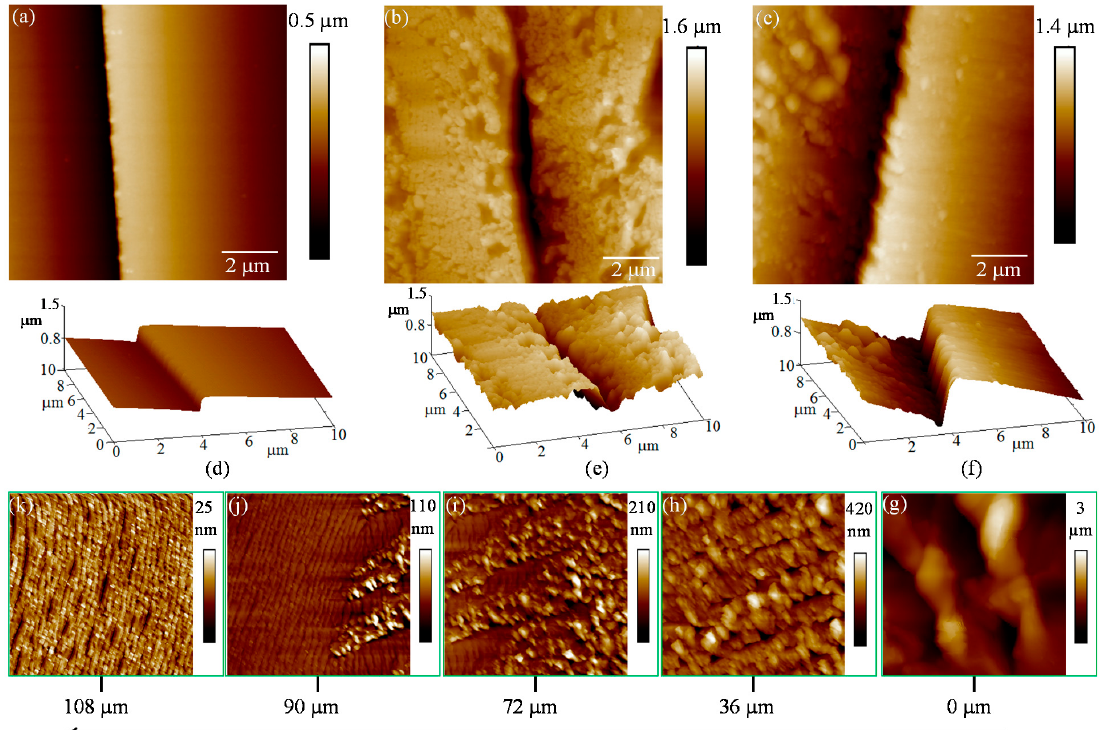
Figure 2. The atomic force microscopy (AFM) images show the profile of PDMS films at the vicinity of an incision. Images ( a – c ) correspond to a PDMS film without any surface modification (set I type of substrate), one plasma oxidized for 4 min (set II type) and one (set III type) consisting of nano- to microscopic wrinkles prepared by the method described in [12]. ( d – f ) Images represent 3D plots of surfaces corresponding to those in images a–c, respectively. ( g – k ) Series of AFM images of surfaces are presented as function of distance from the incision, the location of which is shown in image ( g ). The bar chart of respective images shows that the roughness of the surface decreases with distance away from incision (as indicated by the arrow).